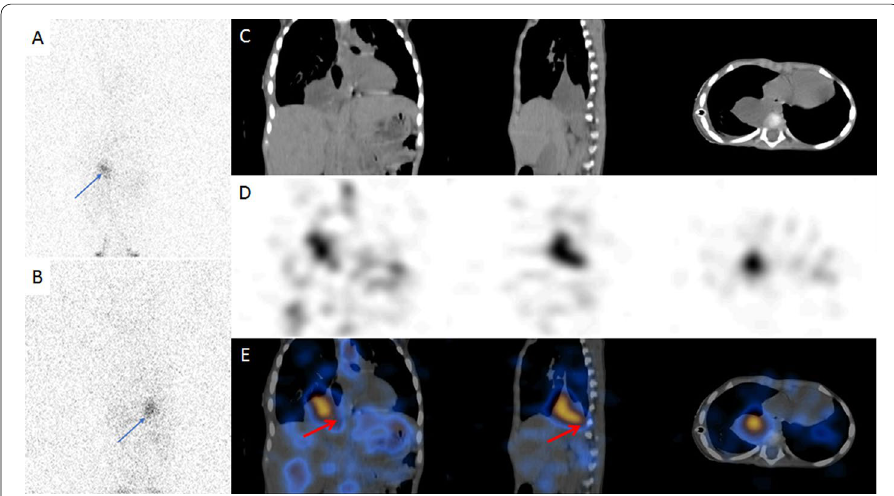
Fig. 2 Tc99m sulphur colloid lymphoscintigraphy anterior (A) and posterior (B) delayed planar images of thorax and abdomen region shows focal accumulation of radiotracer in the right hemithorax region (as shown by blue arrow). SPECT-CT images of thorax and abdomen region showing CT (C), SPECT row (D) and hybrid SPECT-CT (E) images in coronal, sagittal and axial thoracic views. Focal radiotracer accumulation corresponding to well-defined cystic area in the right lower thorax at the level of T8-T11 vertebrae with possible site of leak medially (as shown by the red arrow in the coronal and sagittal views) on hybrid SPECT-CT images